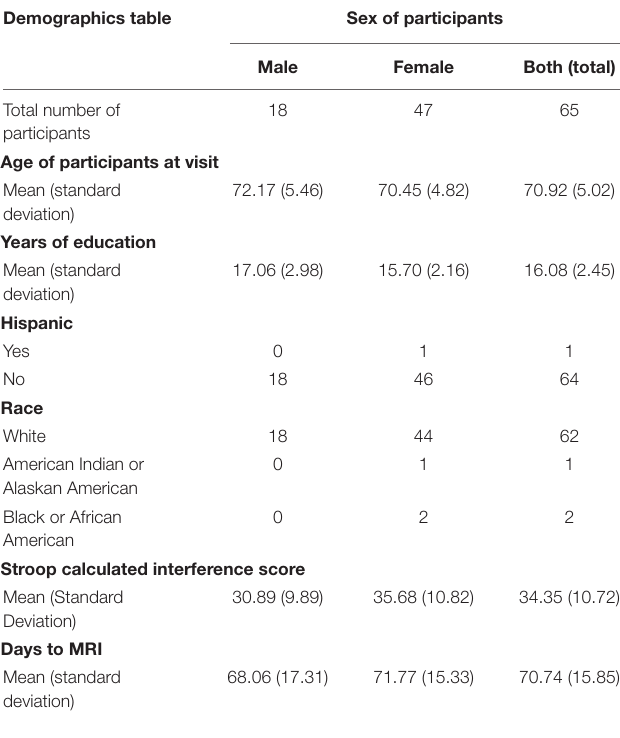
TABLE 1 | Demographics of the 65 participants included in this study who completed resting-state fMRI and the Stroop task within 90 days of one another and did not have excessive motion